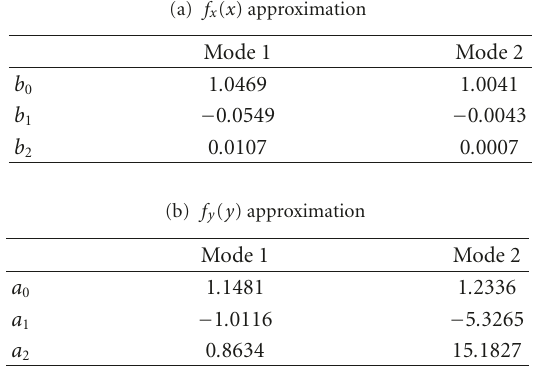
Table 2: Coe ffi cients for first-order correction χ 2 -approximation with CL TD mode 1 and